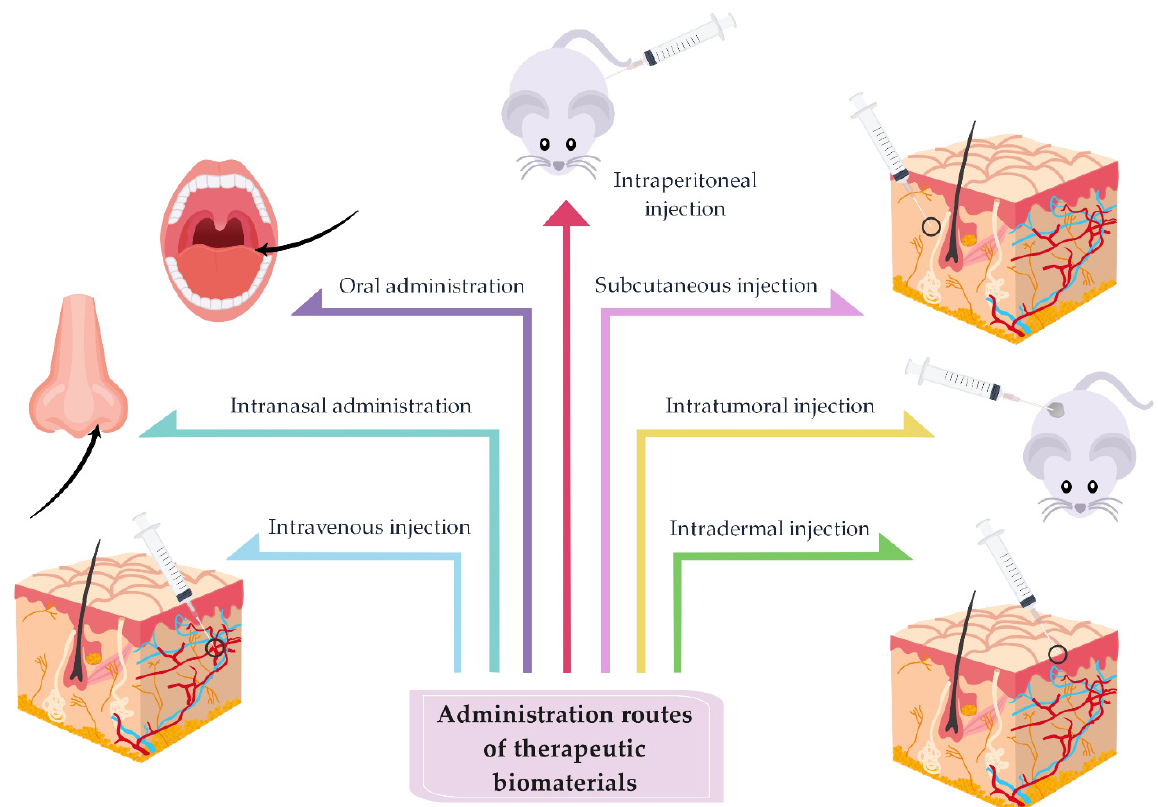
Figure 13. Representative structure of different administration routes of therapeutic biomaterials into the body through drug delivery: intravenous injection, intranasal administration, oral administration, intraperitoneal injection, subcutaneous injection, intratumoral injection, and intradermal injection (summarized from [2,11,102,147,173]).